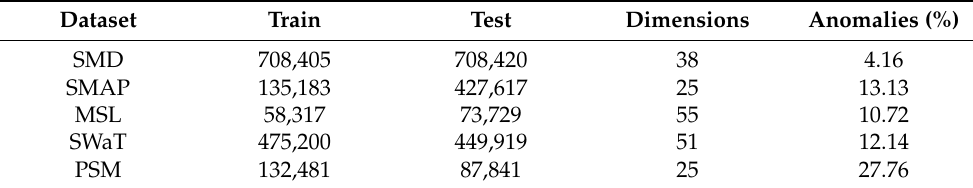
Table 1. Dataset